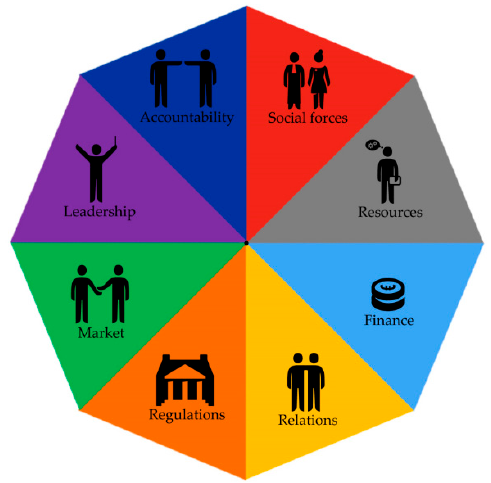
Figure 1. Visualization of Collaborative Adaptive Health Network (CAHN) components .